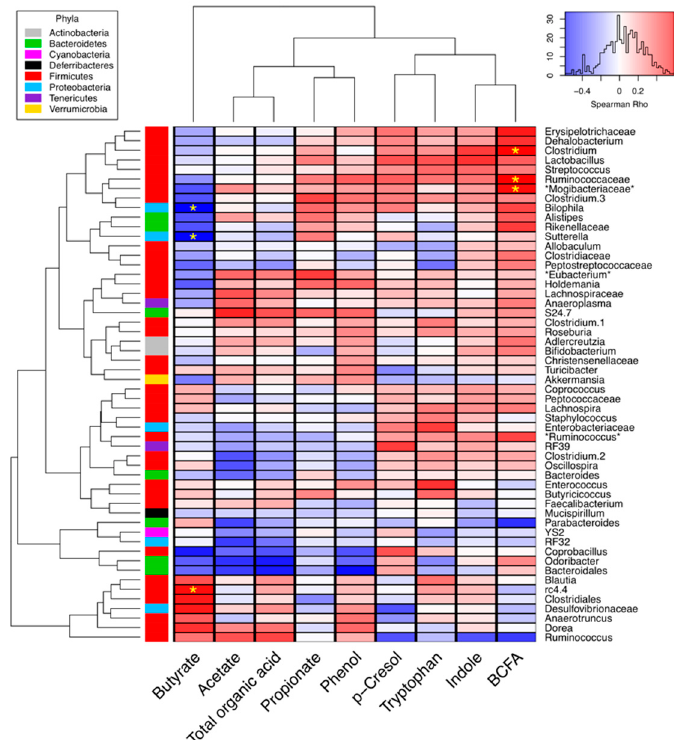
Figure 4. Correlation heatmap between the cecal microbiota and cecal metabolite concentrations. Taxa detected in less than 500 total DNA sequences were removed from the analysis. Blue and red cells in the heatmap represent the negative and positive Spearman rho values, respectively, and yellow asterisks denote the significant correlations (false discovery ratecorrected p < 0.05). The colored vertical bar (left side) shows the corresponding phylum. Predicted annotations from the Greengenes database have asterisks before and after their taxonomic label. Taxa and metabolite dendrograms are based on Euclidean distances between features.